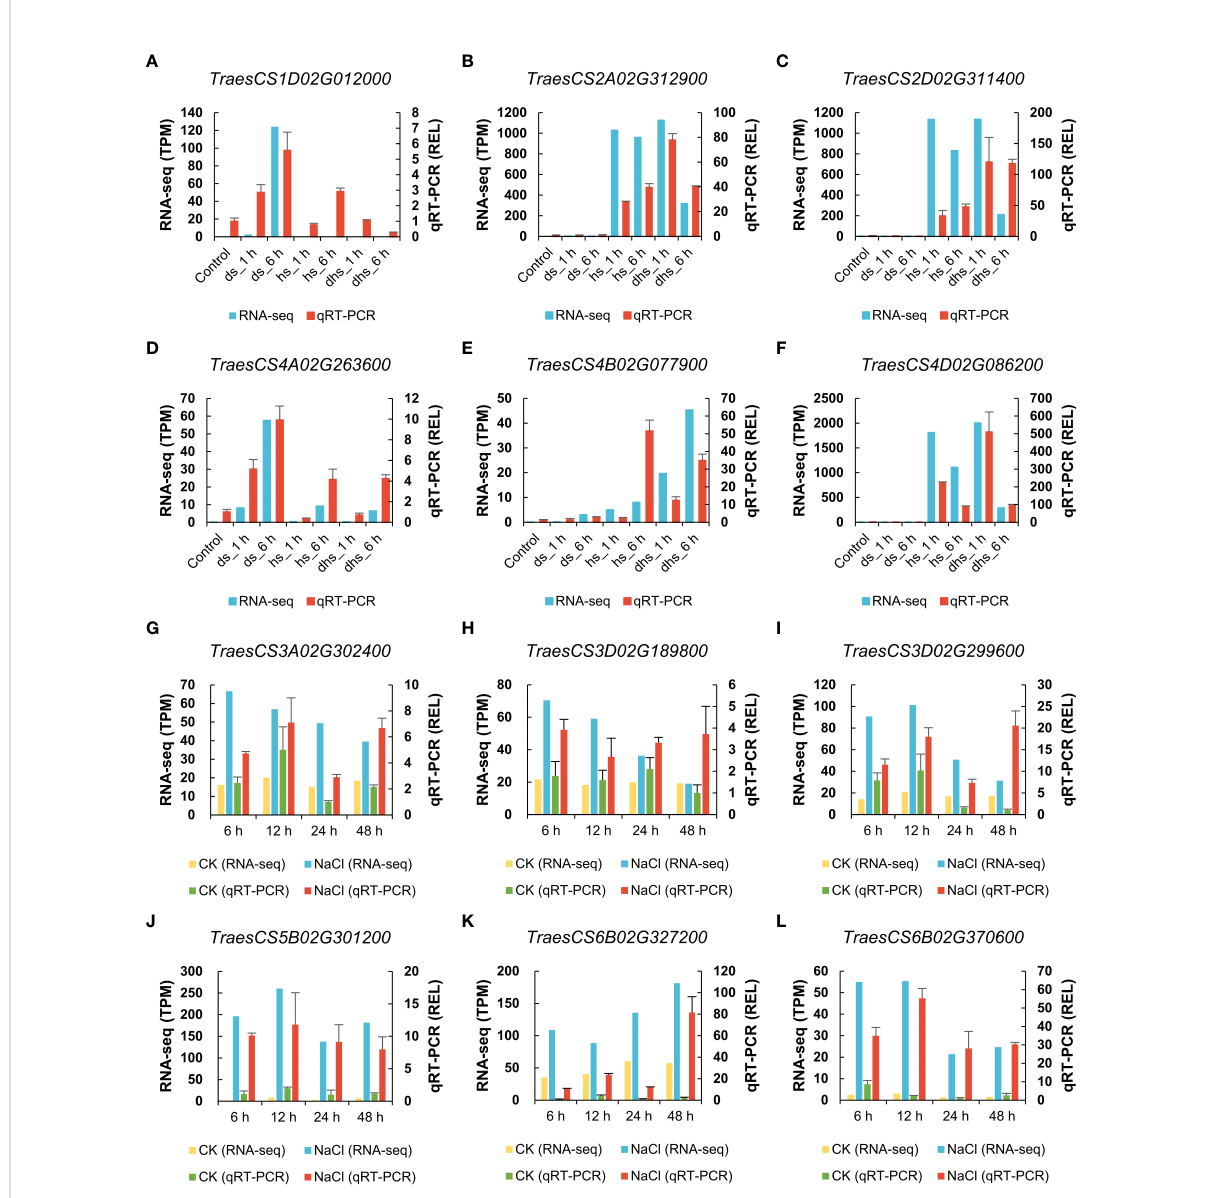
FIGURE 7 Veri fi cation of expression data from RNA-seq using qRT-PCR. (A-F) The expression level of TaSSPs in drought and heat stress. (G-L) The expression level of TaSSPs in salt stress. The highly expressed TaSSP genes were selected randomly for qRT-PCR. The left Y-axis indicates TPM value (Transcripts Per Kilobase Million) from RNA-seq in (A-F) , and TPM relative to control in (G-L) . The right Y-axis indicates relative expression level (REL) based on qRT-PCR. All samples used to perform qRT-PCR were collected based on corresponding samples for RNA-seq. qRT-PCR were performed three biological replicates and two technological